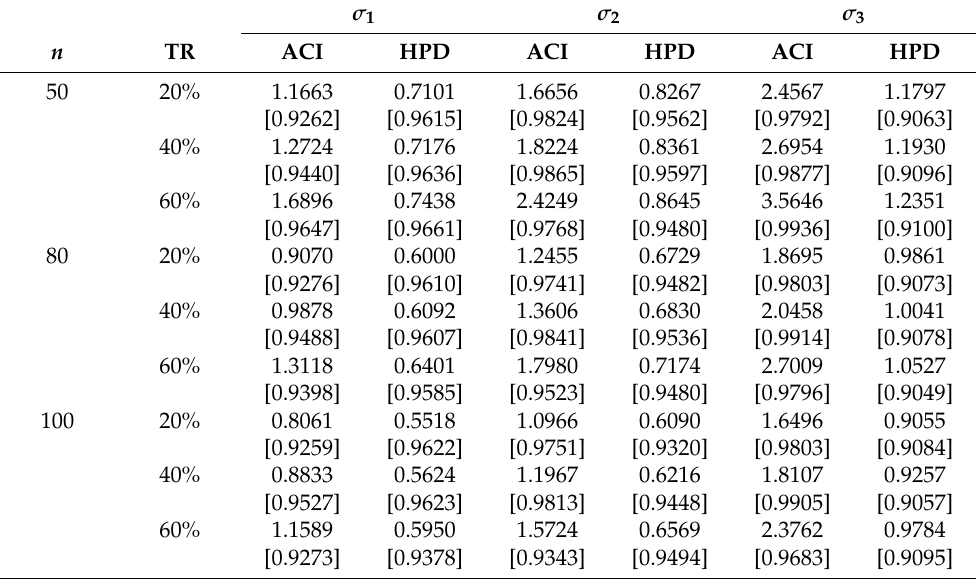
Table 8. ALs and CPs (within bracket) for parameters with order restriction when ( σ 1 , σ 2 , σ 3 ) = ( 1,1.3,2 )